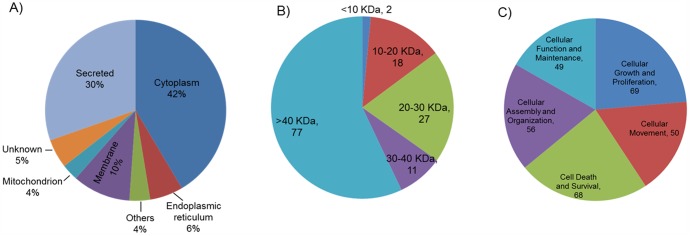
Overview of the A) subcellular location, B) molecular size distribution and C) molecular and cellular functions of the 135 proteins that showed significant variation between irradiated and sham skin tissues.Others: subcellular location known, but not being included in the main categories; Unknown: subcellular location unknown. Protein may have more than one function.